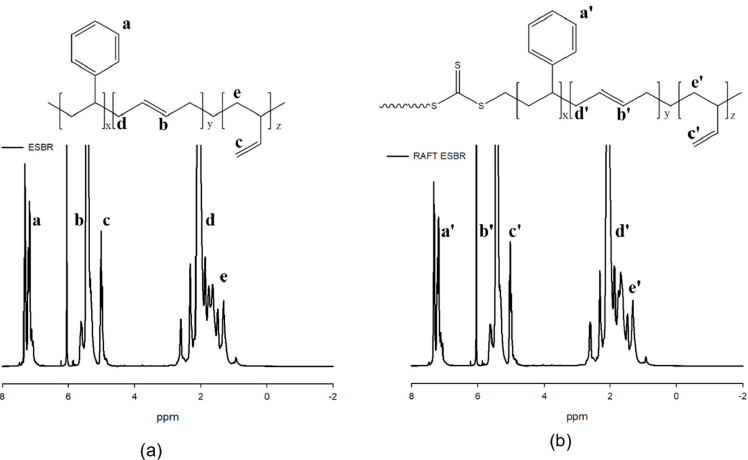
Figure 3. Nuclear magnetic resonance spectrometer (NMR) curves of ( a ) emulsion styrene butadiene rubber (ESBR) and ( b ) reversible addition-fragmentation radical transfer ESBR (RAFT ESBR) raw polymers.